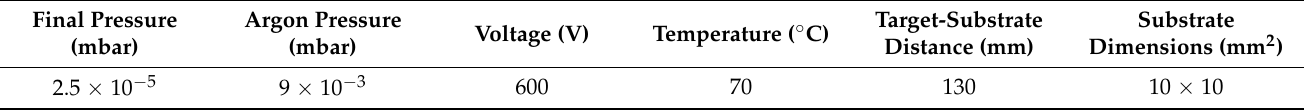
Table 1. The deposition conditions for coating Ag, Au, and Ag–Au thin films.